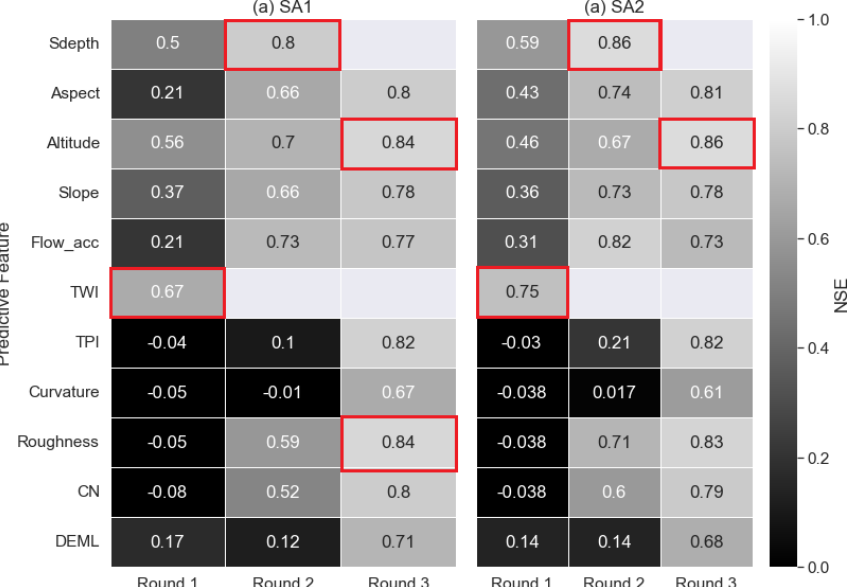
Figure 7. NSE values for SA1 (a) and SA2 (b) for the models trained in the forward selection process for the best performance training data combination (U-Net-SA1&2). The best performance model in every round is marked in red.